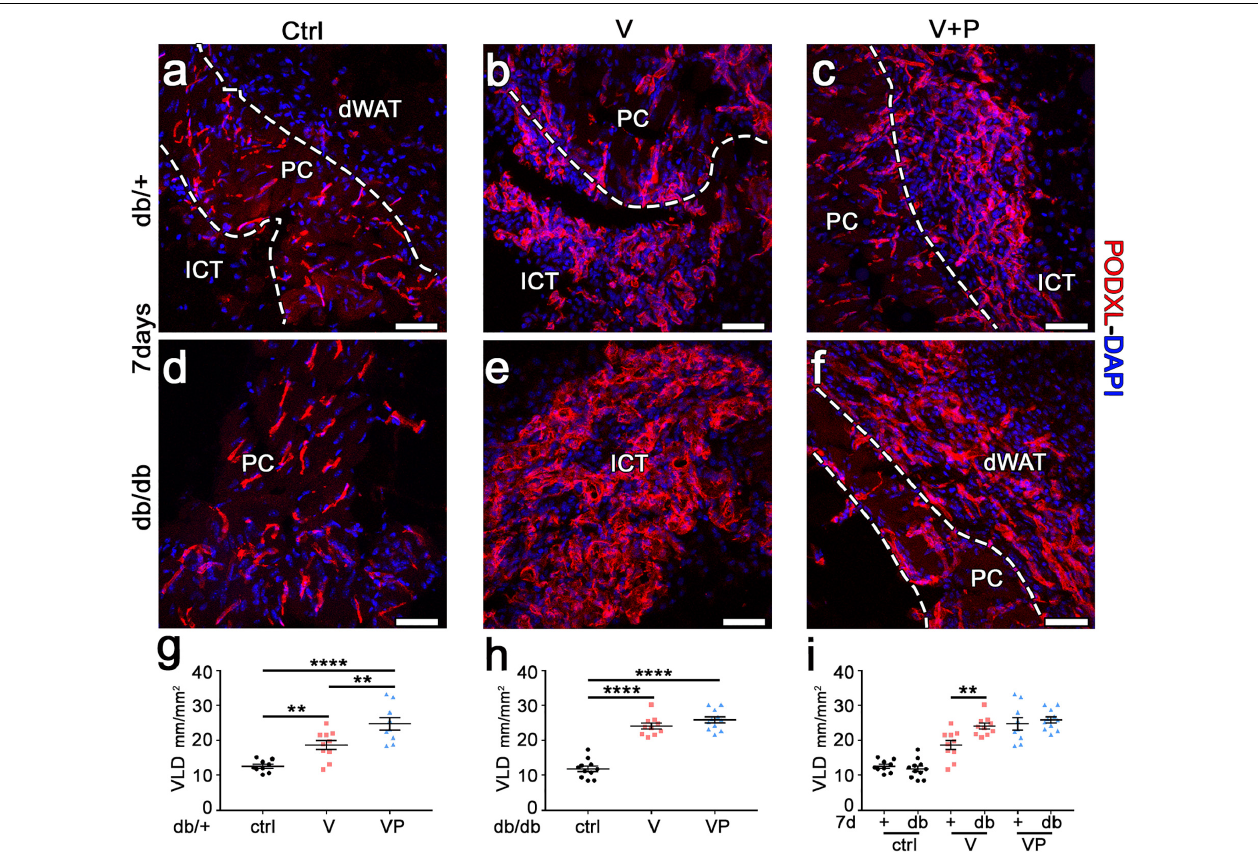
FIGURE 3 | TG-VEGF and TG-PDGF-BB enable robust vessel formation in diabetic skin. (a–f) Cryosections of dorsal skin of db/+ (+) and db/db (db) mice, harvested 7 days after injection of V, VP, and control (ctrl) fibrin gels, were immunostained for podocalyxin (endothelial cells, red) and DAPI (nuclei, blue); dWAT, dermal adipose white tissue; PC, panniculus carnosus; ICT, interstitial connective tissue. (g–i) The amount of angiogenesis was quantified as VLD, vessel length density, expressed as millimeters of vessel length per square millimeter of area of effect (mm/mm 2 ). Data represent mean values of each sample ± SEM ( n = 9–11 samples/group). ** p < 0.01, **** p < 0.0001 by 1-way ANOVA with Sidak and Tukey multiple comparisons test. Scale bars = 50 µ m in all panels.